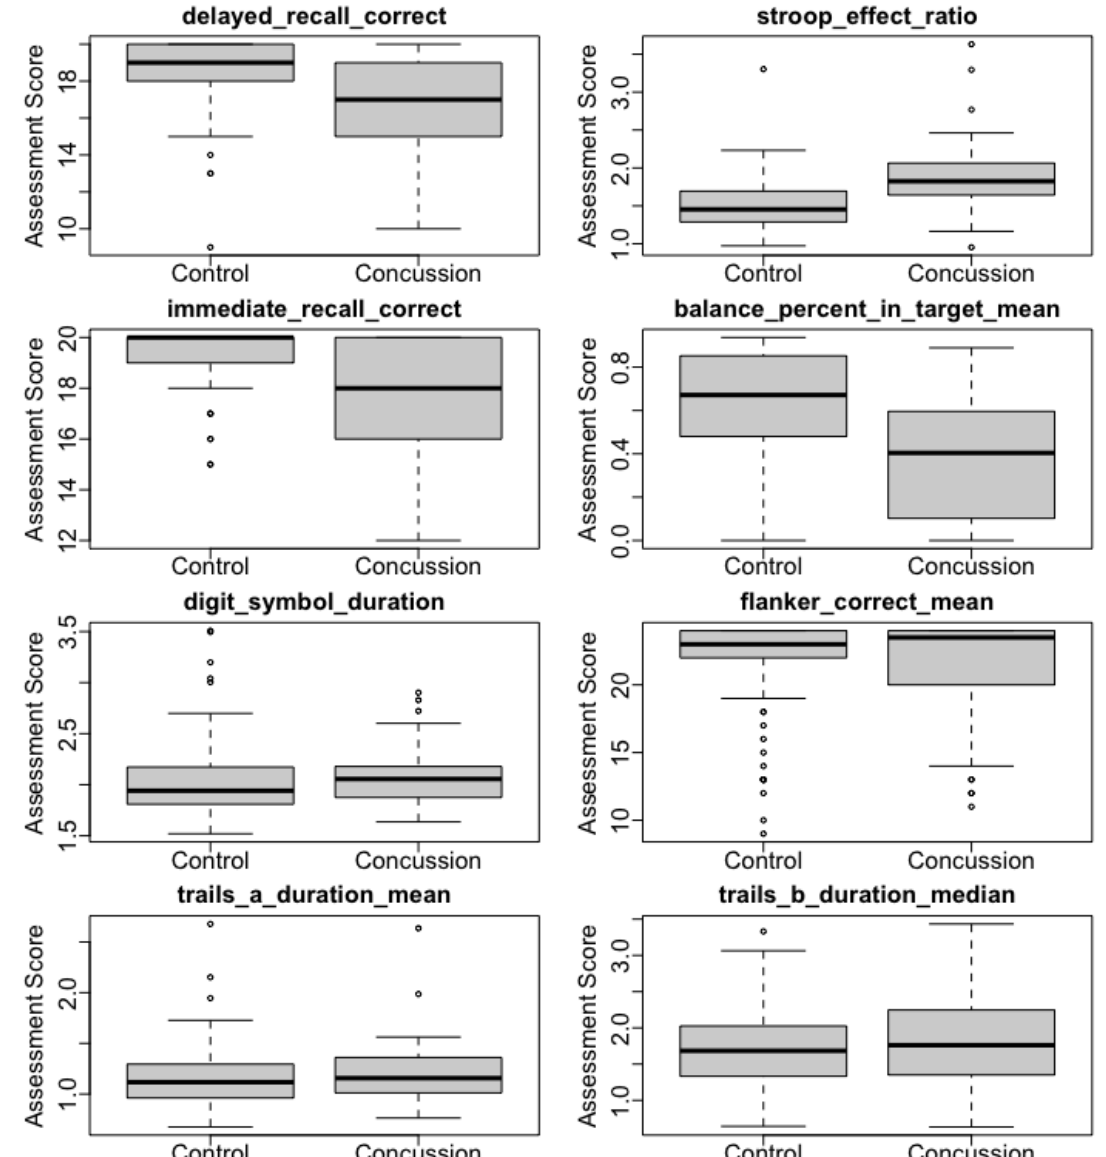
Figure 3. Boxplots of BrainCheck Sport assessment metrics for the control group and the mTBI